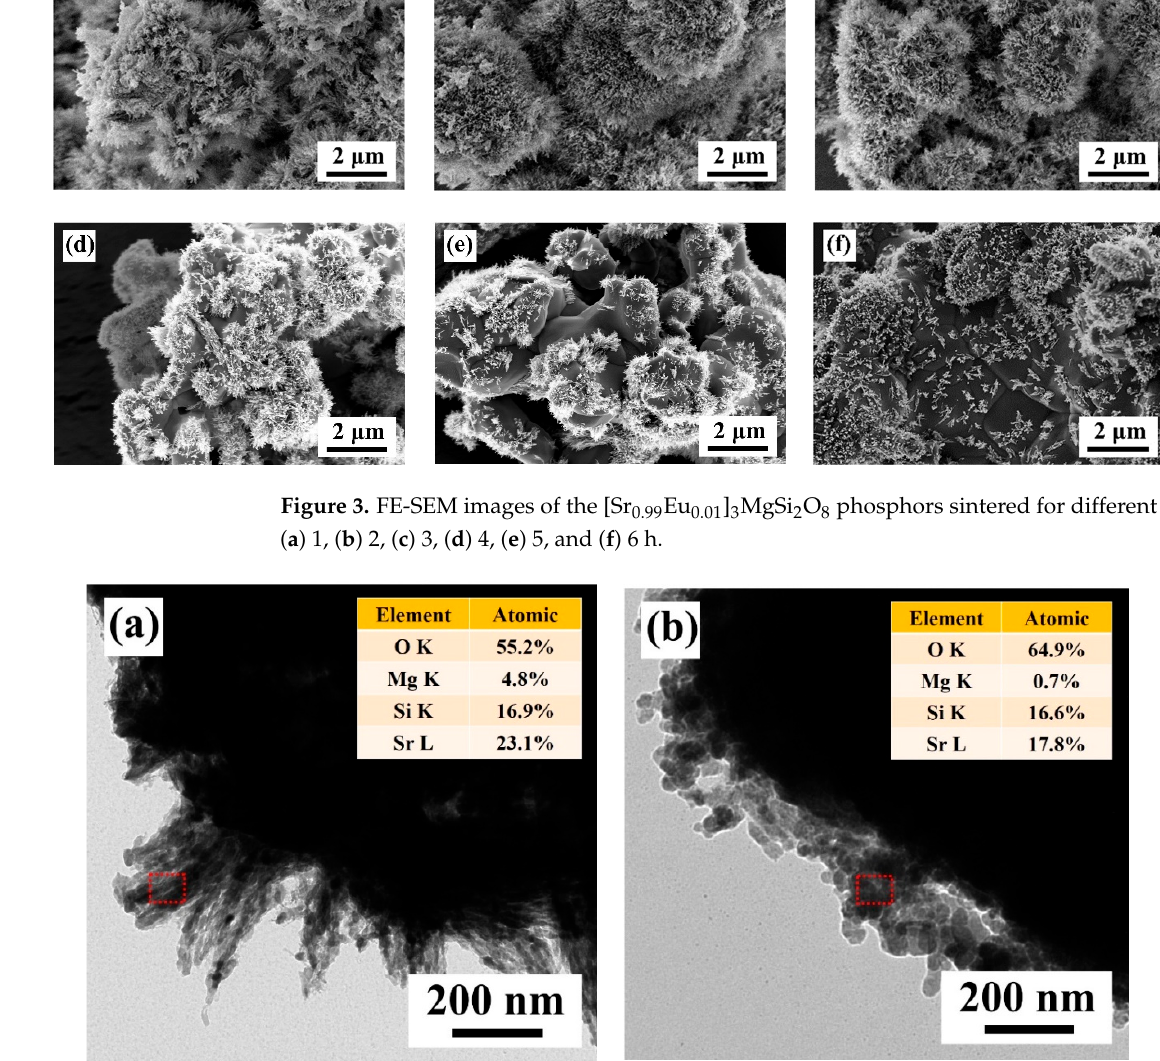
Figure 4. HR - TEM images of the [Sr 0.99 Eu 0.01 ] 3 MgSi 2 O 8 phosphors sintered for different durations: ( a ) 1 and ( b ) 5 h. The EDS results are shown in the inset.